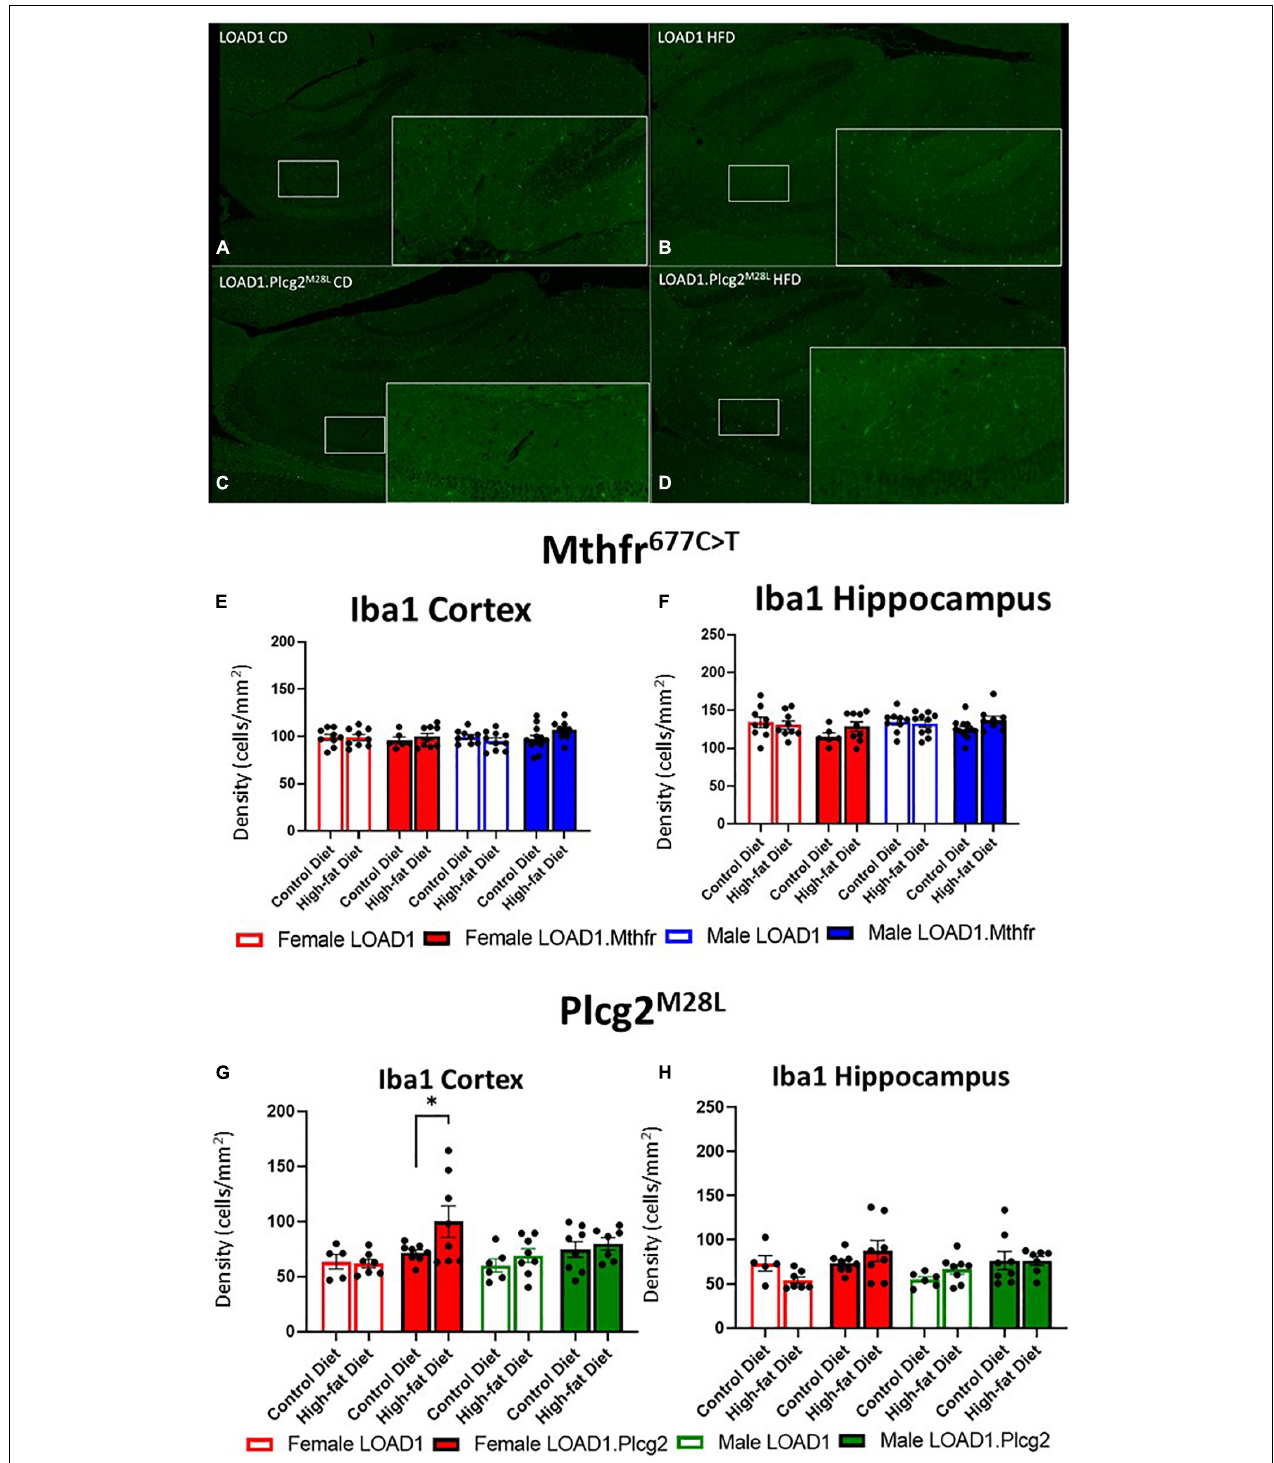
FIGURE 3 | Microglial density is increased in LOAD1. Plcg2 M 28 L high fat diet mice. Immunohistochemistry was completed using Iba1 to visualize the density of microglia (A–D) in the LOAD1. Plcg2 M 28 L mice. LOAD1. Mthfr 677 C > T mice did not show any significant changes in microglia density in the cortex (E) or hippocampus (F) , regardless of diet. However, female LOAD1. Plcg2 M 28 L was found to have an increase in the microglial density in the cortex of the mice fed with HFD (G) . No changes were observed in LOAD1. Plcg2 M 28 L mice fed with the control diet (CD) (G,H) . Data suggest a gene by diet interaction that may be sex-specific. Statistical analysis was completed using an ANOVA followed by Tukey’s post hoc tests. P < 0.05 is considered significant.